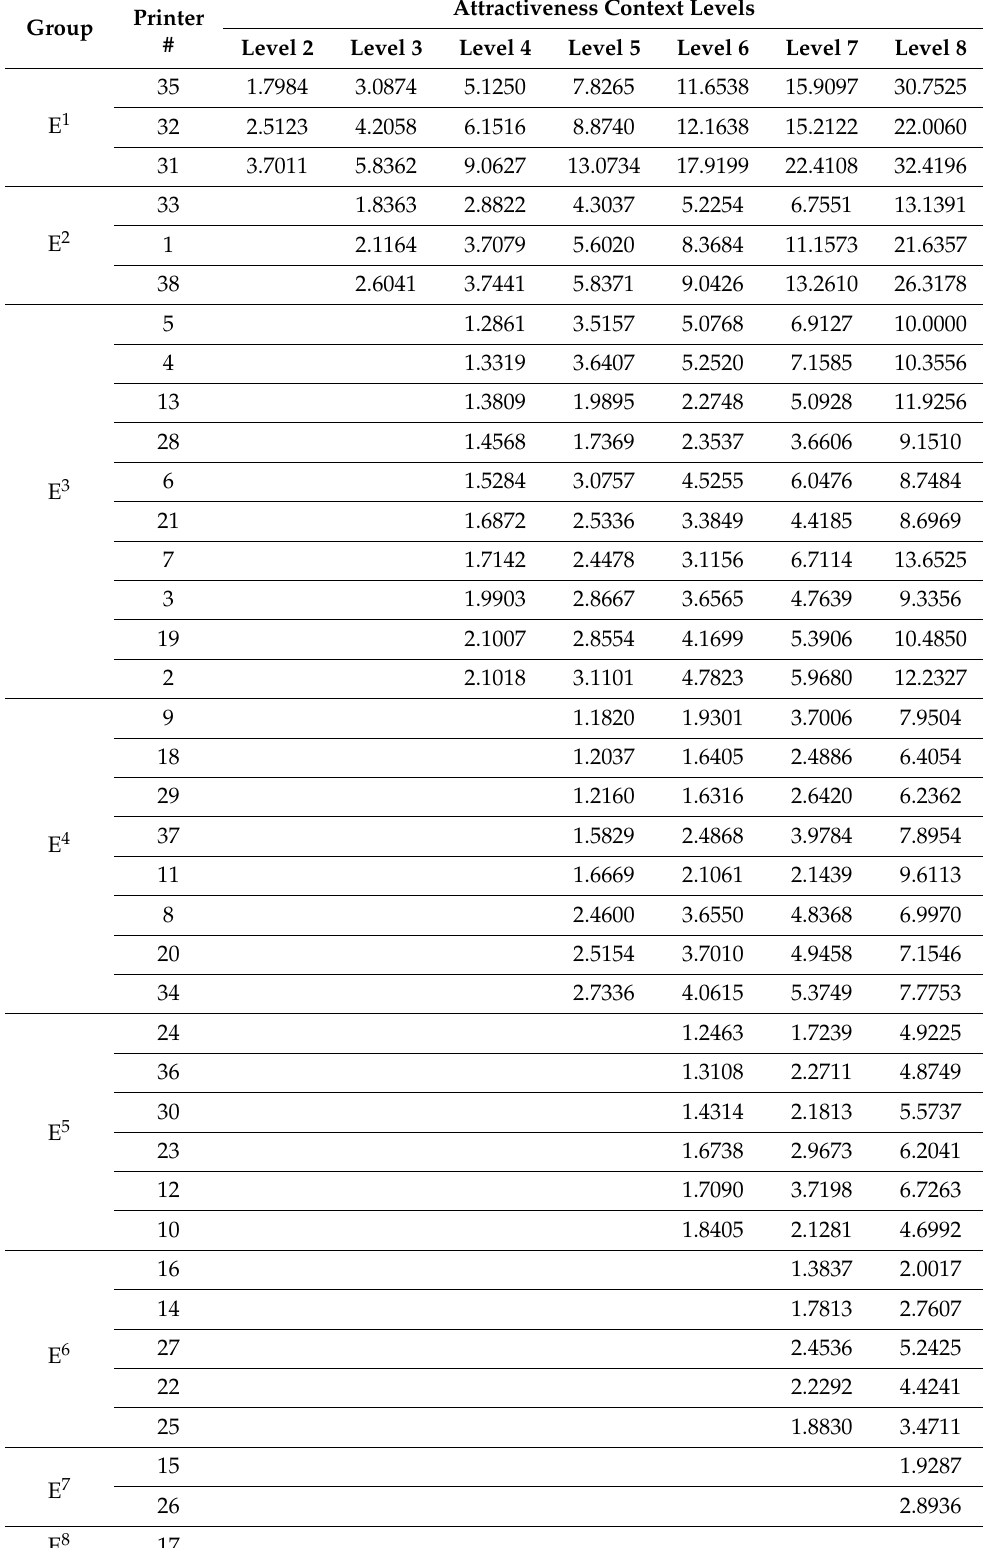
Table 9. Attractiveness context